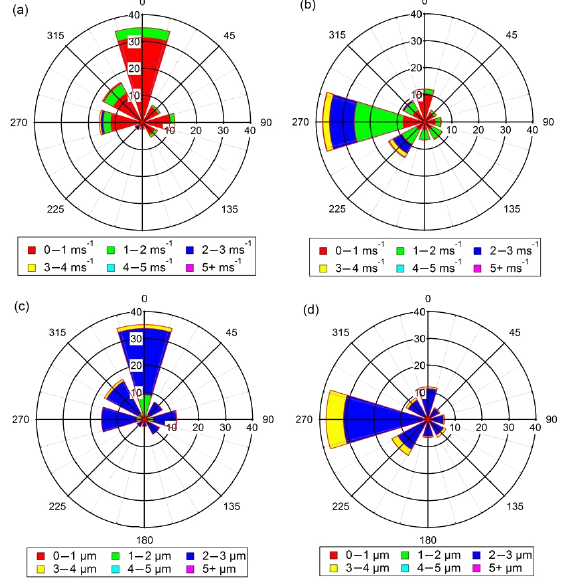
Figure 13. Same as Fig. 12 but scaled by the geometric mean diam- eter ( D g ) of d N F / dlog D a . (a) Entire campaign, (b) dusty period, (c) clean period, and (d) high bio period.